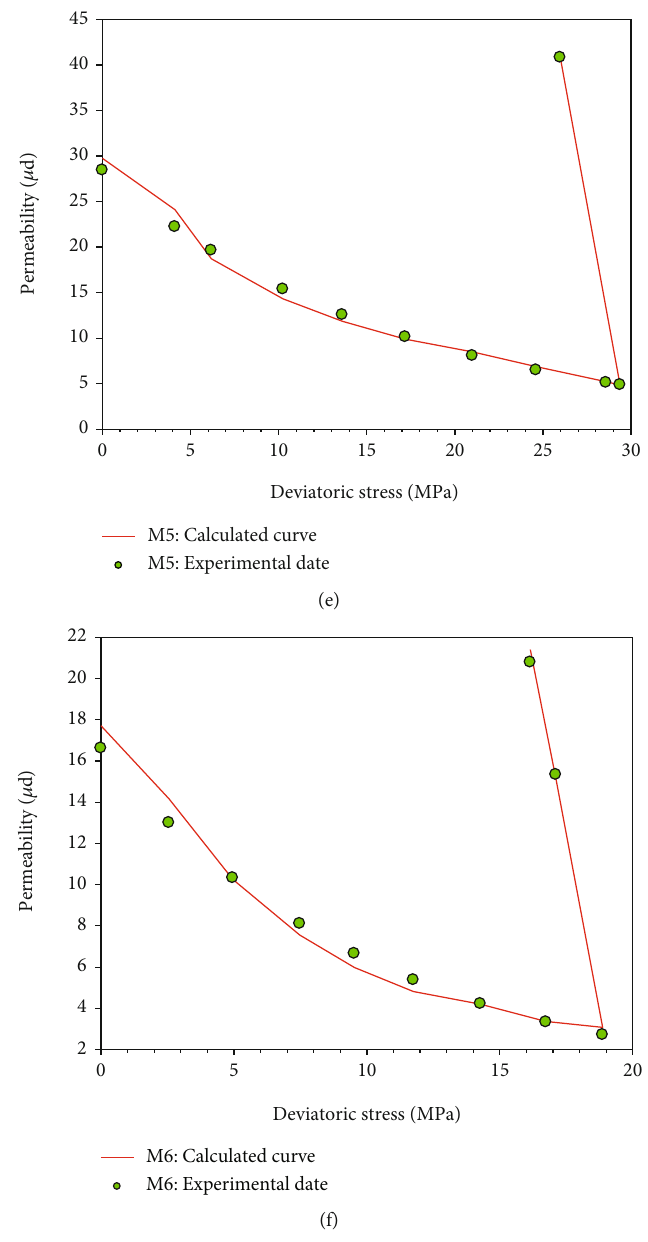
Figure 7: Experimental and theoretical values of permeability and deviatoric